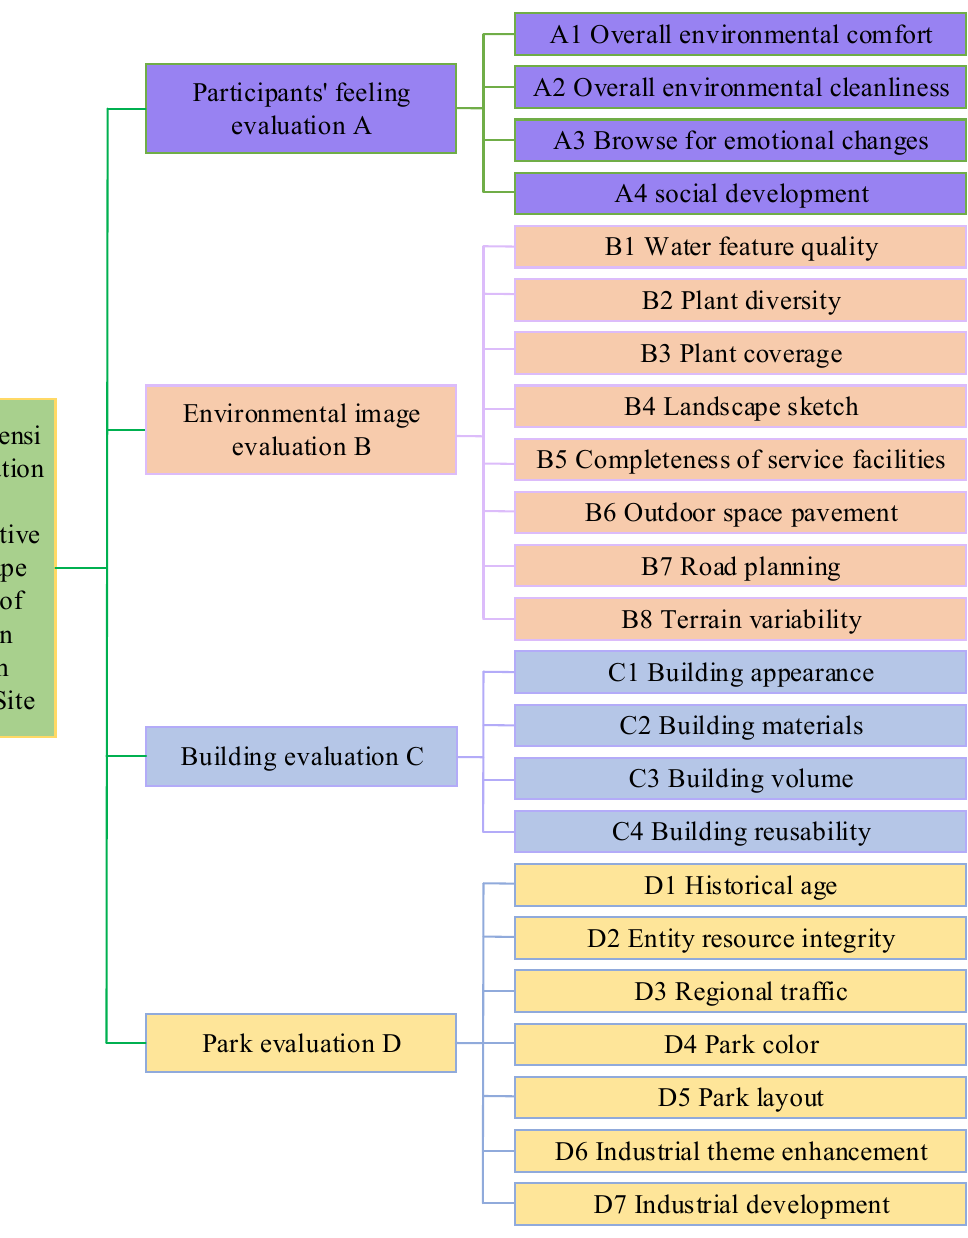
Figure 3. Evaluation Index System of Regenerative Landscape Design of Kailuan System Factory Site.